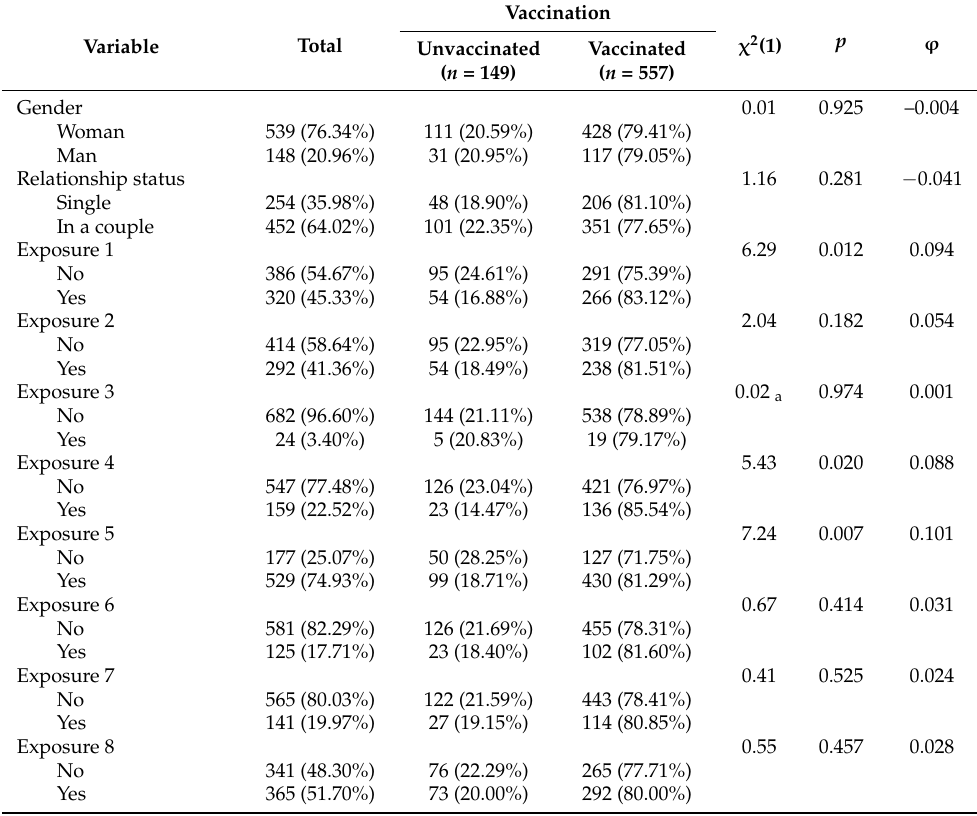
Table 1. Demographic variables and exposure to COVID-19 in the university students’ sample ( n = 706).